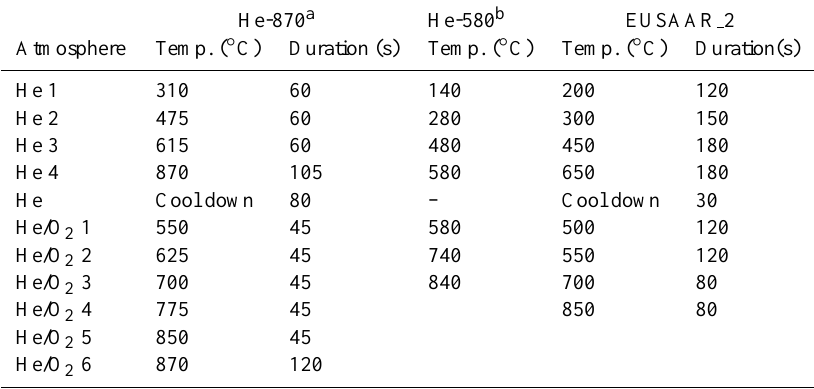
Table 1. Thermal protocols tested in this